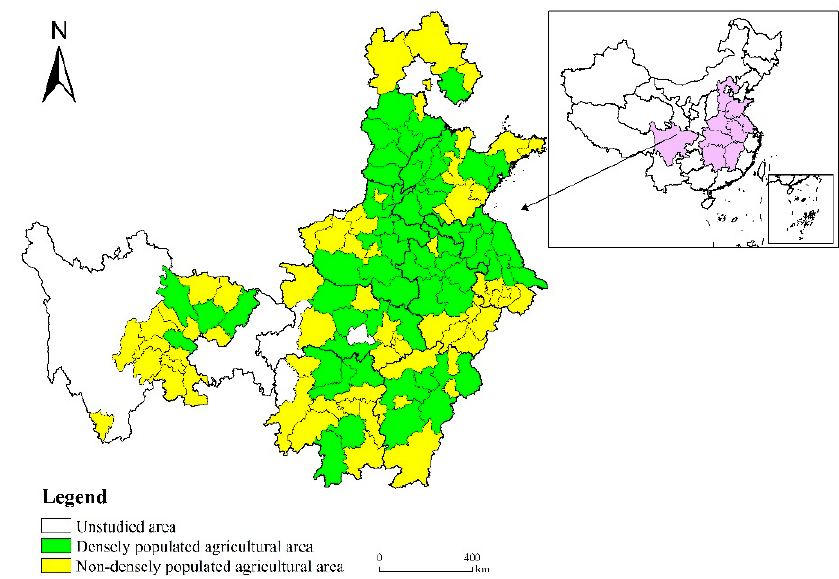
Figure 2. Locations of MGPAs including 128 prefecture-level cities in China.